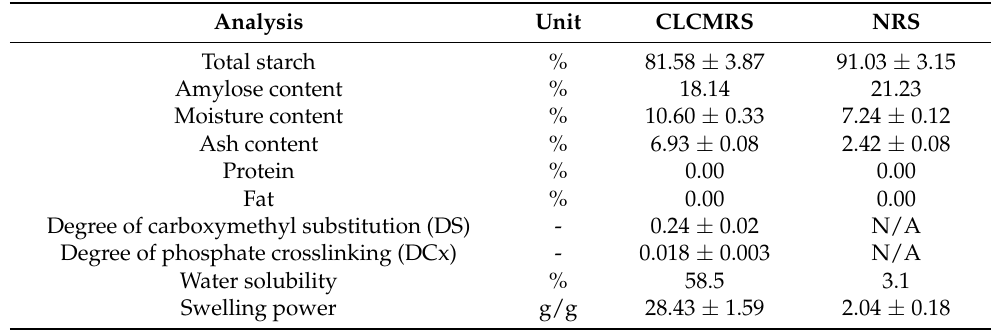
Table 2. Analysis results of crosslinked carboxymethyl rice starch (CLCMRS) powder in comparison with native rice starch (NRS)